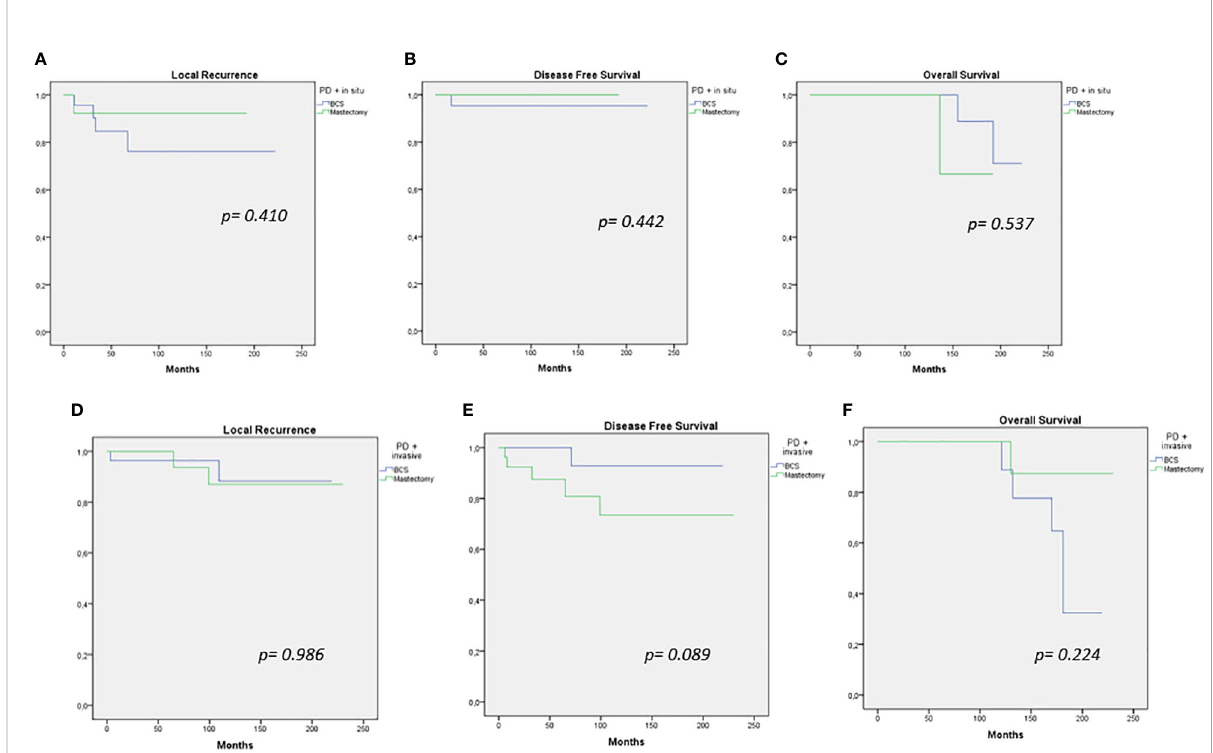
FIGURE 2 Local recurrence, disease-free survival, and overall survival curves for breast-conserving therapy versus mastectomy in PD + in situ (A – C) and PD + invasive cancer (D – F)